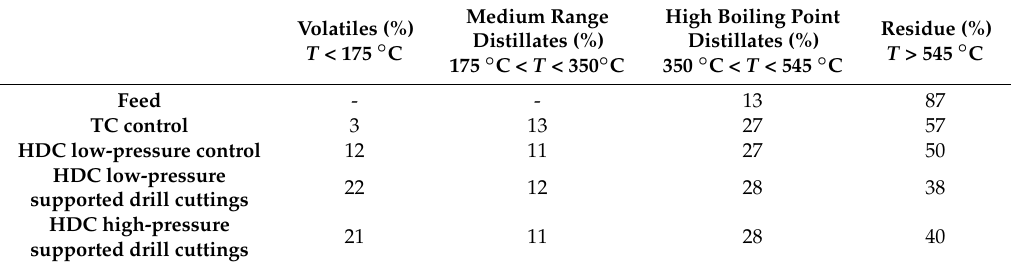
Table 4. Distillation cuts present in the product oil from various runs. Volatiles (<n-C 10 ), medium